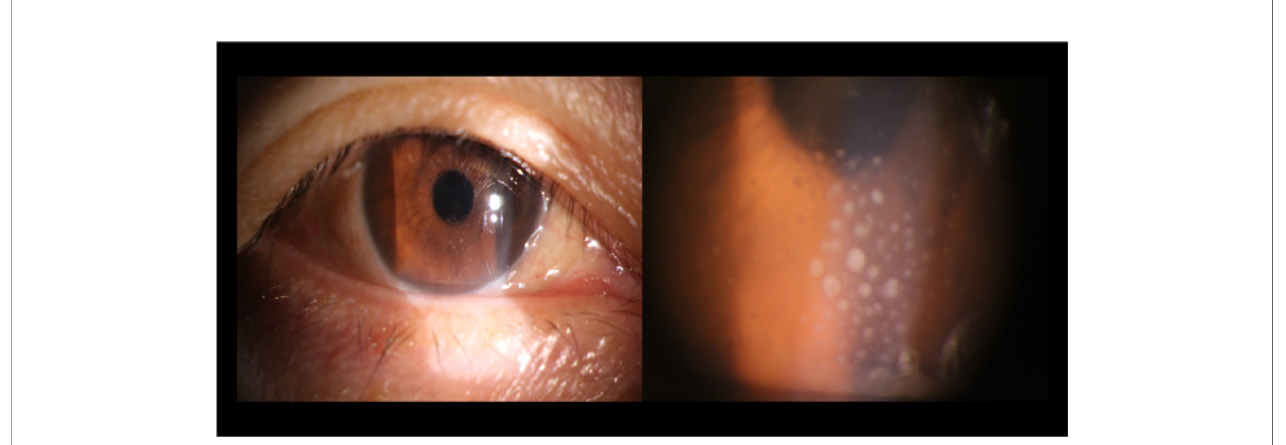
FIGURE 1 | Typical anterior segment photographs of